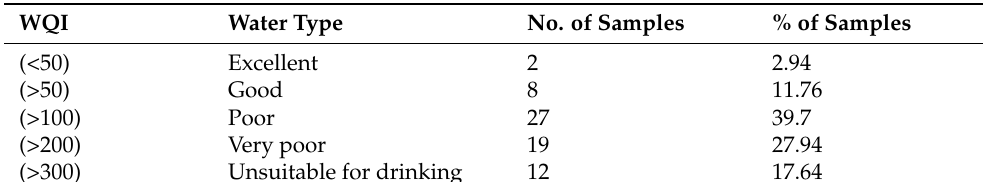
Table 4. Water Quality Index (WQI) classification of the study area.